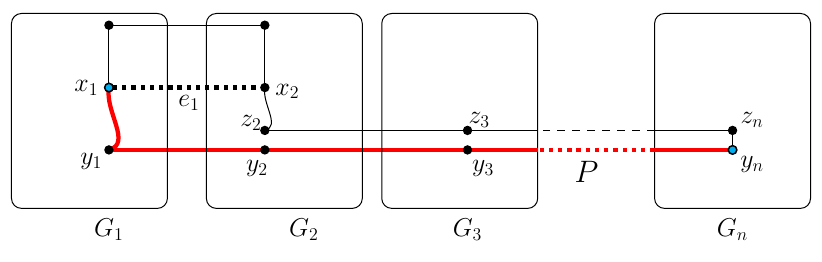
Figure 4: The cycle D containing P